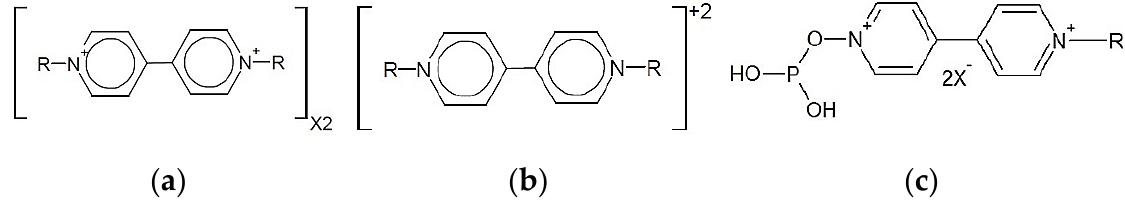
Figure 4. Viologen: ( a ) general chemical formulae of viologen; ( b ) viologen ion; ( c ) general structure for viologens modifying the titania surface. Table 2 shows a general classification of EC. Table 2. General classification of EC.